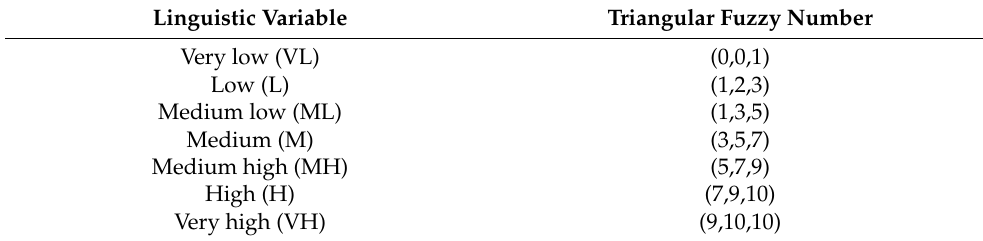
Table 2. Linguistic variables for rating the vehicle failure